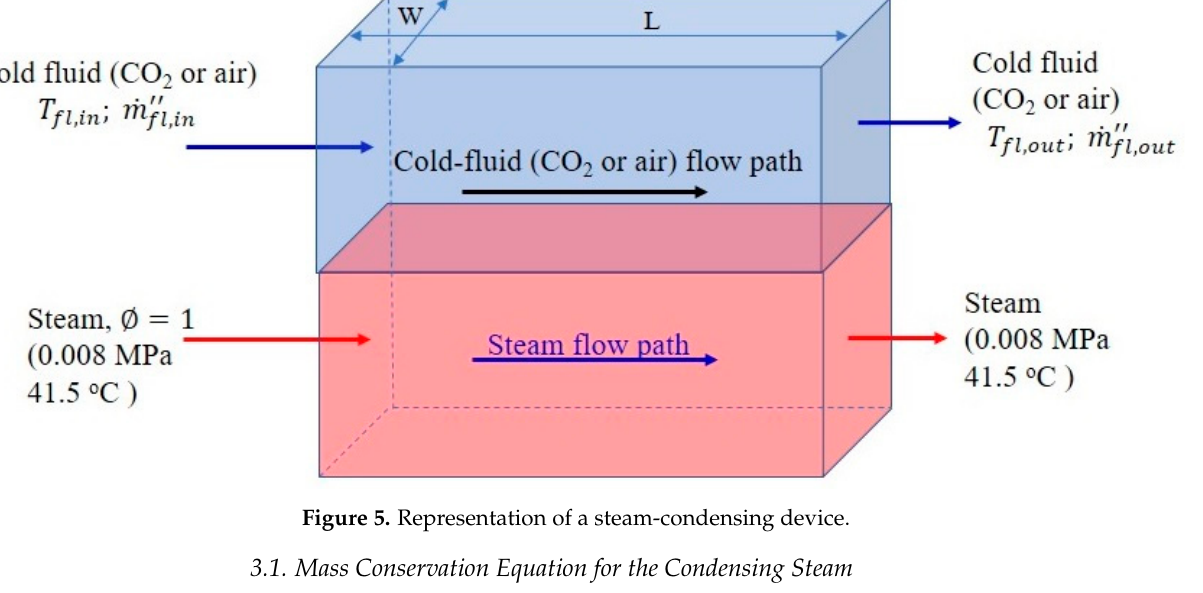
Figure 5. Representation of a steam-condensing device.